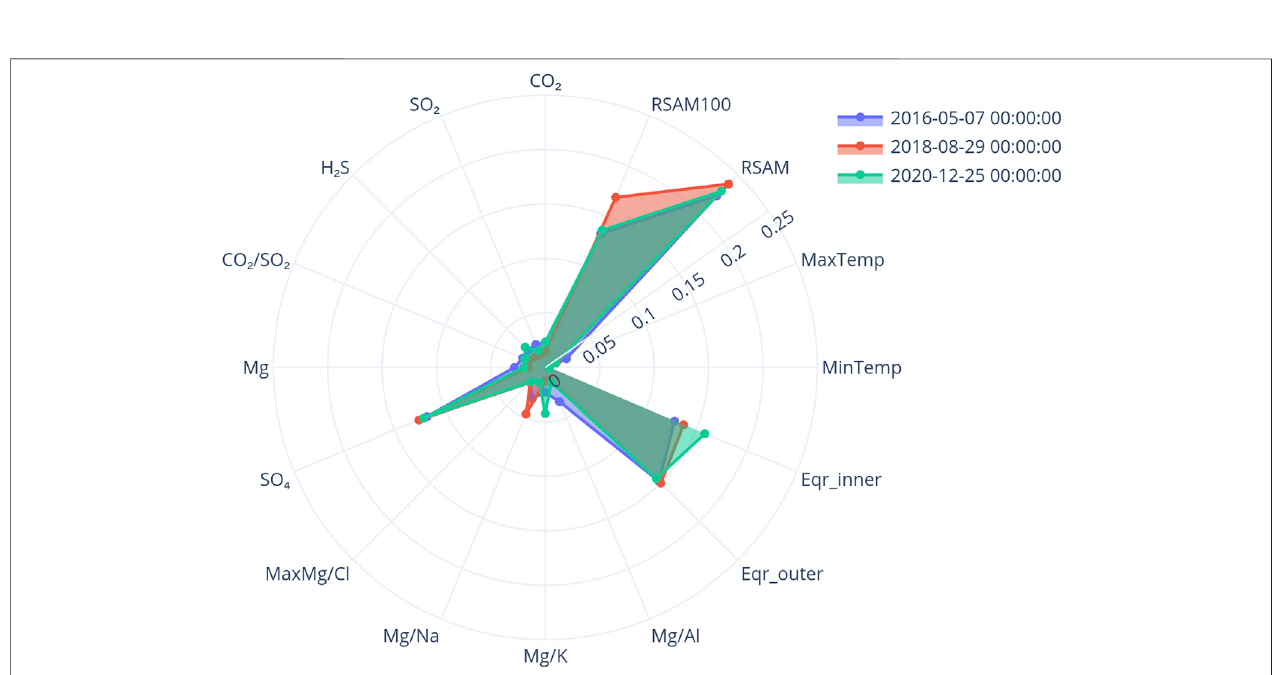
FIGURE 12 | Normalised parameter sensitivity plots for 3 dates from each time interval